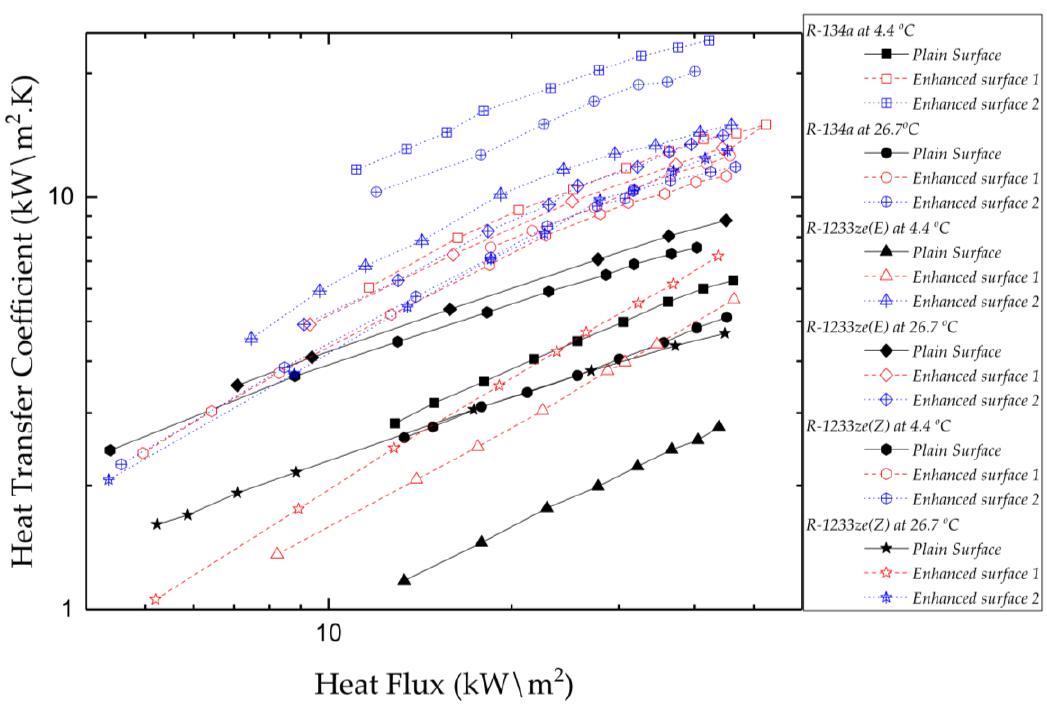
Figure 8. Influence of the plain and two enhanced surfaces on HTCs [45].